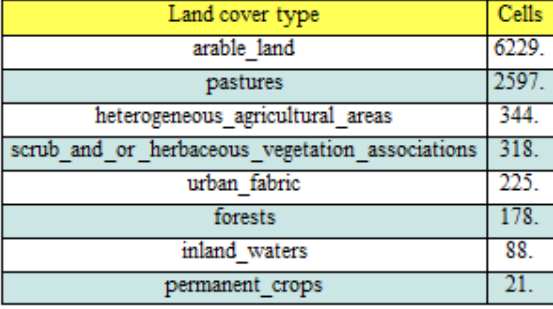
Table 2. The land cover composition of Figure 5.